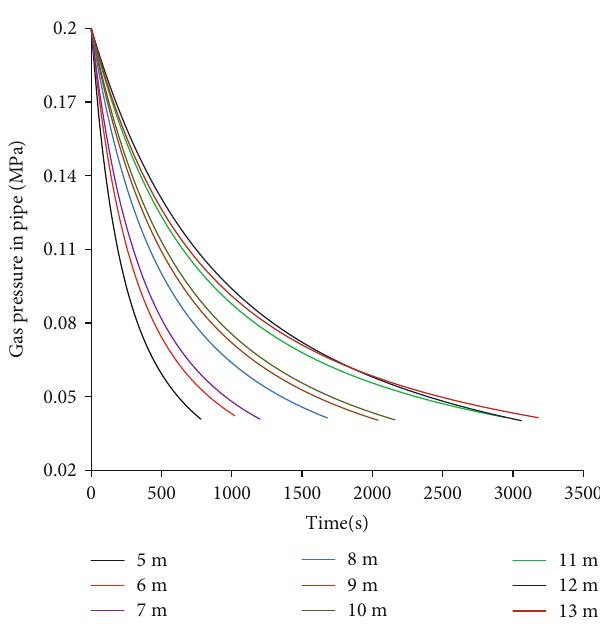
Figure 13: Pressure attenuation curves in boreholes at di ff erent depths with